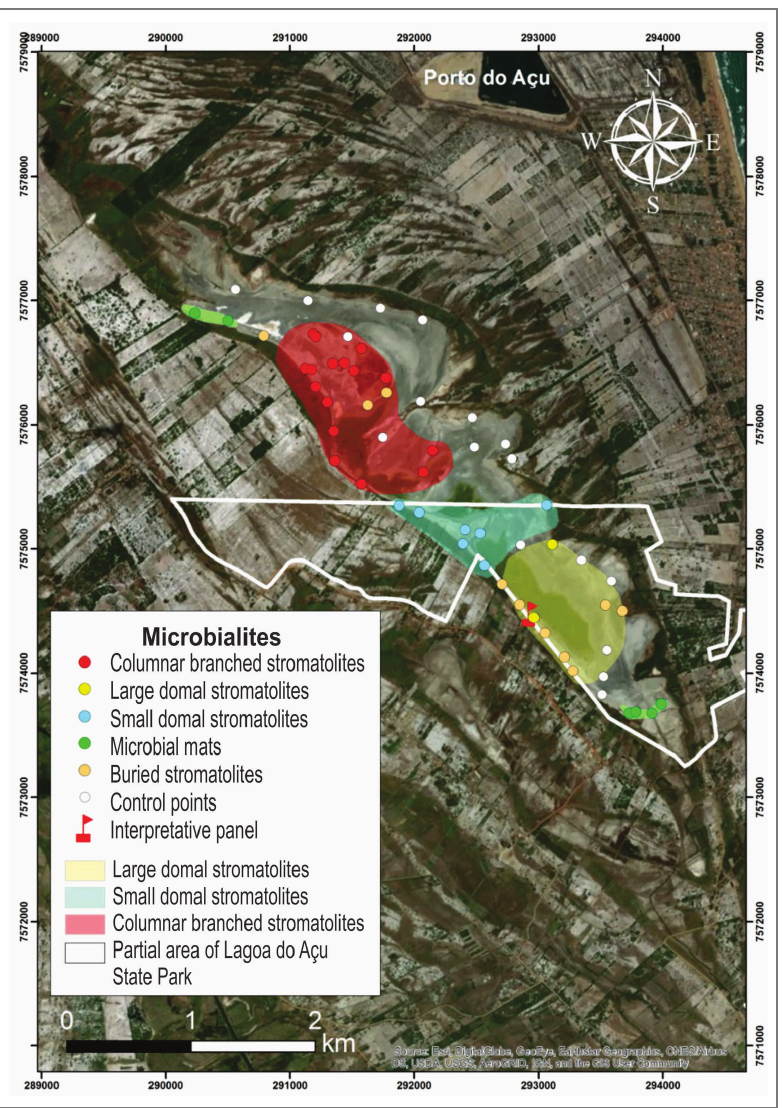
Figure 12 - Map demonstrating the location of microbialites of Lagoa Salgada and the area of the Lagoa do Açu State Park (Adapted from Silva